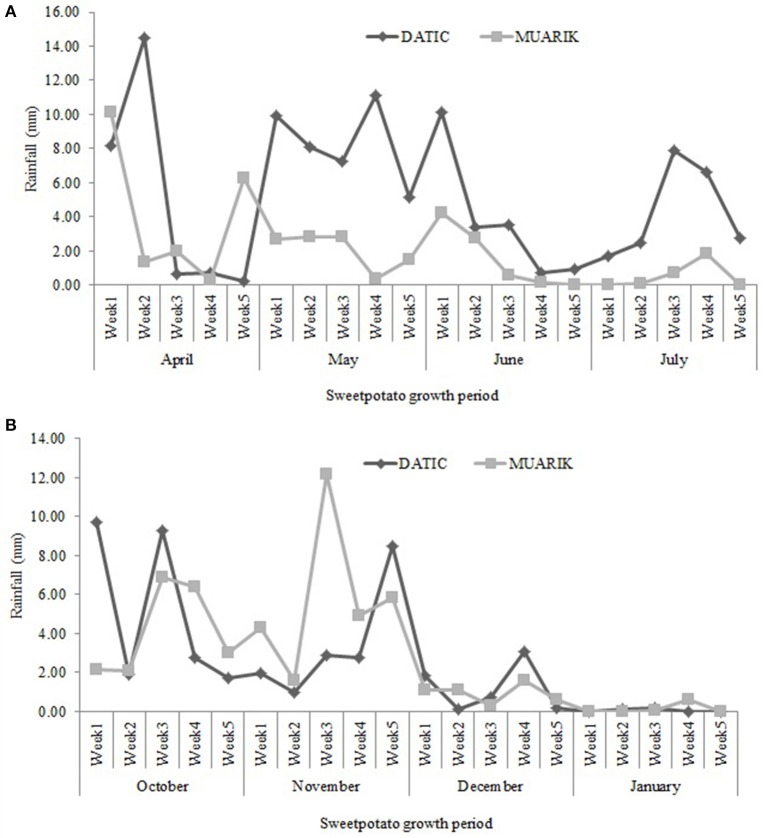
Rainfall distribution at DATIC and MUARIK sites for the (A) long-rain season (April to July, 2014) and (B) the short-rain season (October, 2014–January, 2015).